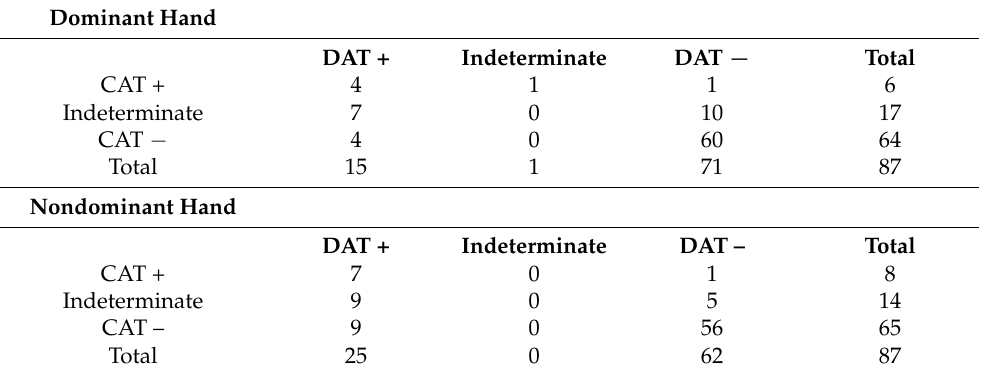
Table 2. Correlation between Clinical Allen Test (CAT) and Doppler Allen Test (DAT) in dominant and nondominant hand.